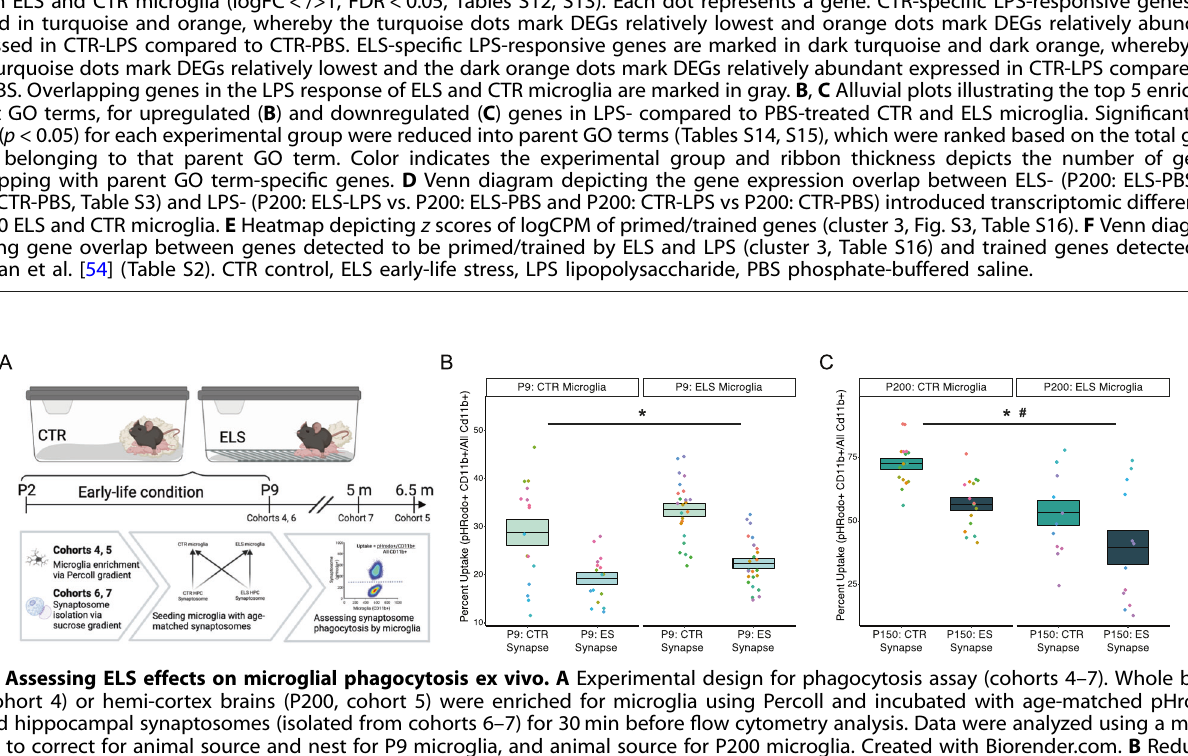
Fig. 4 Assessing ELS effects on microglial phagocytosis ex vivo. A Experimental design for phagocytosis assay (cohorts 4 – 7). Whole brain (P9, cohort 4) or hemi-cortex brains (P200, cohort 5) were enriched for microglia using Percoll and incubated with age-matched pHrodo- labeled hippocampal synaptosomes (isolated from cohorts 6 – 7) for 30 min before fl ow cytometry analysis. Data were analyzed using a mixed model to correct for animal source and nest for P9 microglia, and animal source for P200 microglia. Created with Biorender.com. B Reduced uptake of labeled hippocampal synaptosomes isolated from P9-ELS mice as compared to those from CTR mice, independent of early-life condition of microglia source. C At P200, ELS synapses are phagocytosed less than CTR synapses, with a trend towards decreased uptake by ELS microglia. Mixed effect linear model, *: synaptosome-condition effect, p < 0.05, #: microglia-condition effect, p = 0.05. CTR control, ELS early-life stress, HPC hippocampus. Center values represent the mean, and boundaries of the box plots represent the ELS impacts the microglia gene expression response to an LPS challenge in adulthood To determine if ELS alters the transcriptional response of microglia to a systemic immune challenge, we compared microglial transcriptomes of P200 CTR and ELS mice i.p. injected with either PBS or LPS. We identi fi ed shared (gray dots, 810), CTR-speci fi c ( CTR-PBS , turquoise dots, 299; CTR-LPS , orange dots, 423), and ELS- speci fi c (E LS-PBS , dark turquoise dots, 253; ELS-LPS , dark orange dots, 236) genes dysregulated in response to LPS (Fig. 3A, Tables S12, S13). Measurement of plasma levels of select cytokines (IFN ɣ , IL-6, IL- 10, MCP-1 and TNF) con fi rmed the effectiveness of LPS injections (Fig. S3A), without further modulation by ELS. LPS-induced upregulated genes in both conditions, as expected, were associated with in fl ammatory response GO terms, such as “ cytokine-mediated signaling pathway ” , “ positive regulation of cytokine production ” , “ regulation of apoptotic process ” (Fig. 3B, gray ribbons, Table S14). Shared downregulated genes in LPS- exposed CTR and ELS mice were related to GO terms such as “ double-strand break repair via homologous recombination ” , “ positive regulation of autophagy ” , and “ regulation of protein- containing complex assembly ” (Fig. 3C, gray ribbons, Table S15).